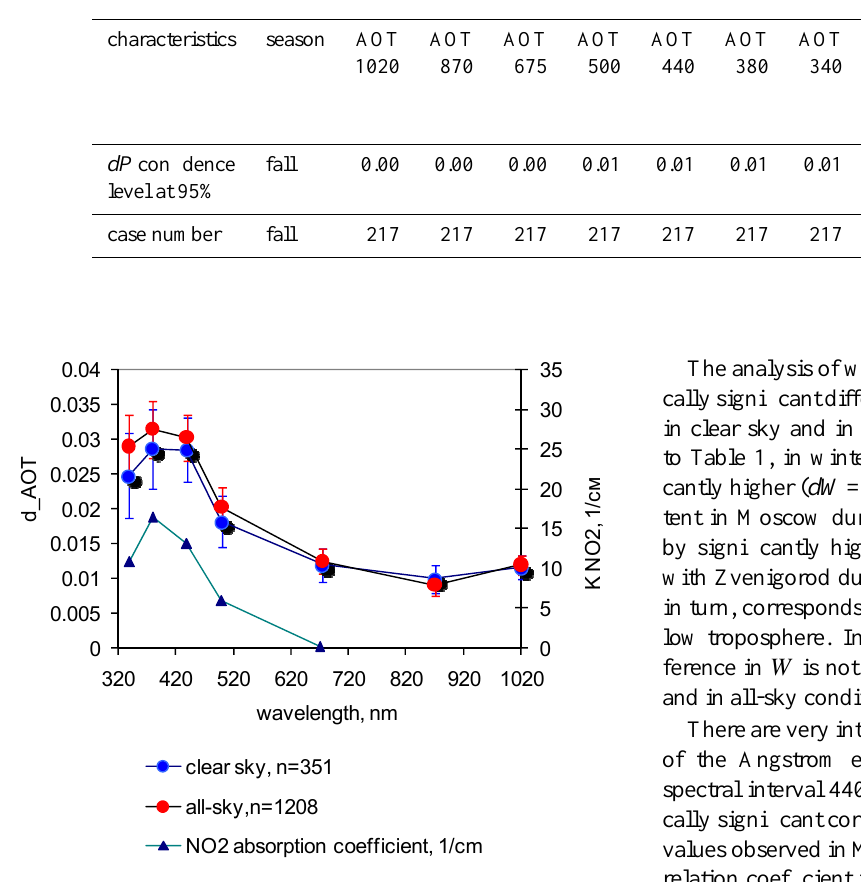
Fig. 3. Spectral dependence of the mean difference in AOT (dAOT) Fig.3. Spectral dependence of the mean difference in AOT (dAOT) between Moscow and between Moscow and Zvenigorod (left axis) and NO 2 absorption coefficients ( K NO ) in CIMEL channels (right axis). The spectral Zvenigorod (left axis) and NO 2 absorption coefficients (K NO2 ) in CIMEL channels ( right axis). 2 dependence of dAOT obtained in clear sky conditions is shown in blue ( n =351); in all-sky conditions – in red color ( n The spectral dependence of dAOT obtained in clear sky conditions is shown in blue (n=351); in all-sky conditions -in red color (n=1209).